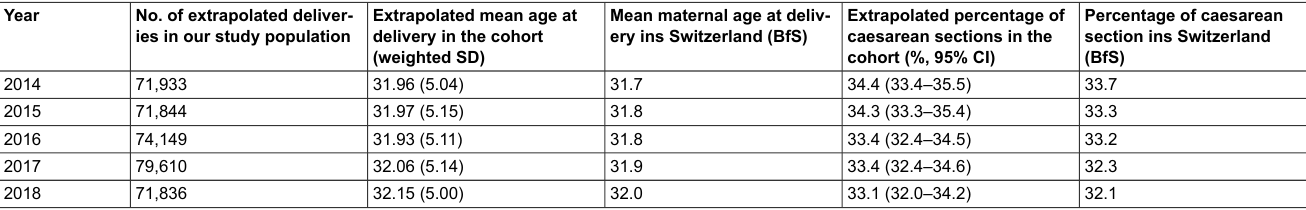
Table 1: Description of the extrapolated/weighted study population. Year No. of extrapolated deliver- ies in our study population